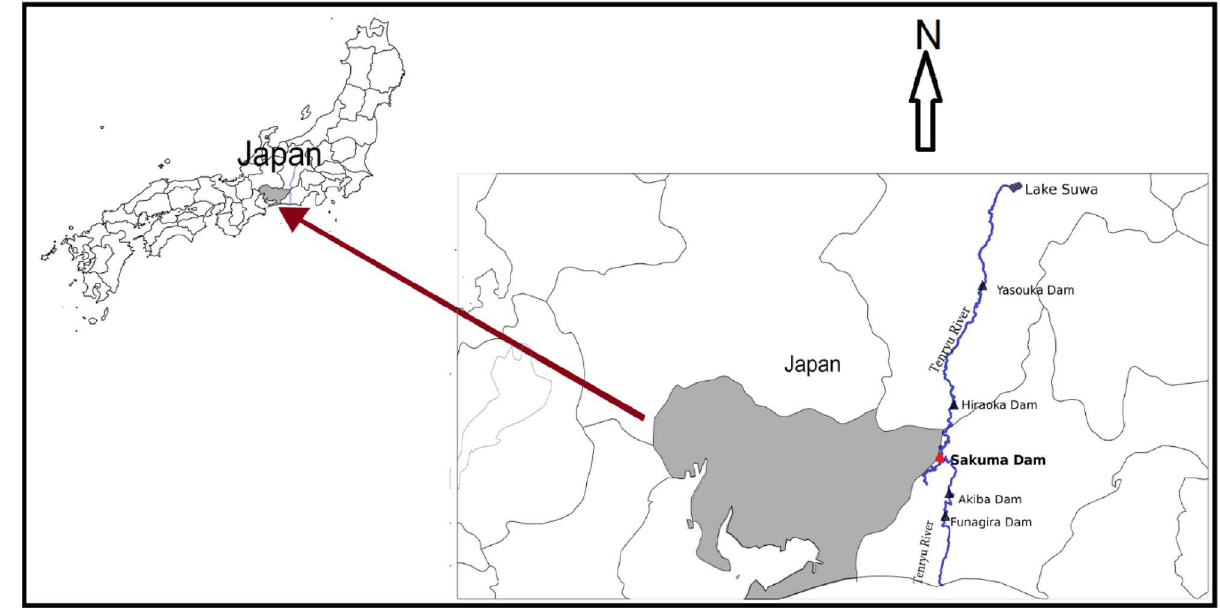
Fig 1. Tenryu River and its dams, the selected reach of Tenryu River is also identified.